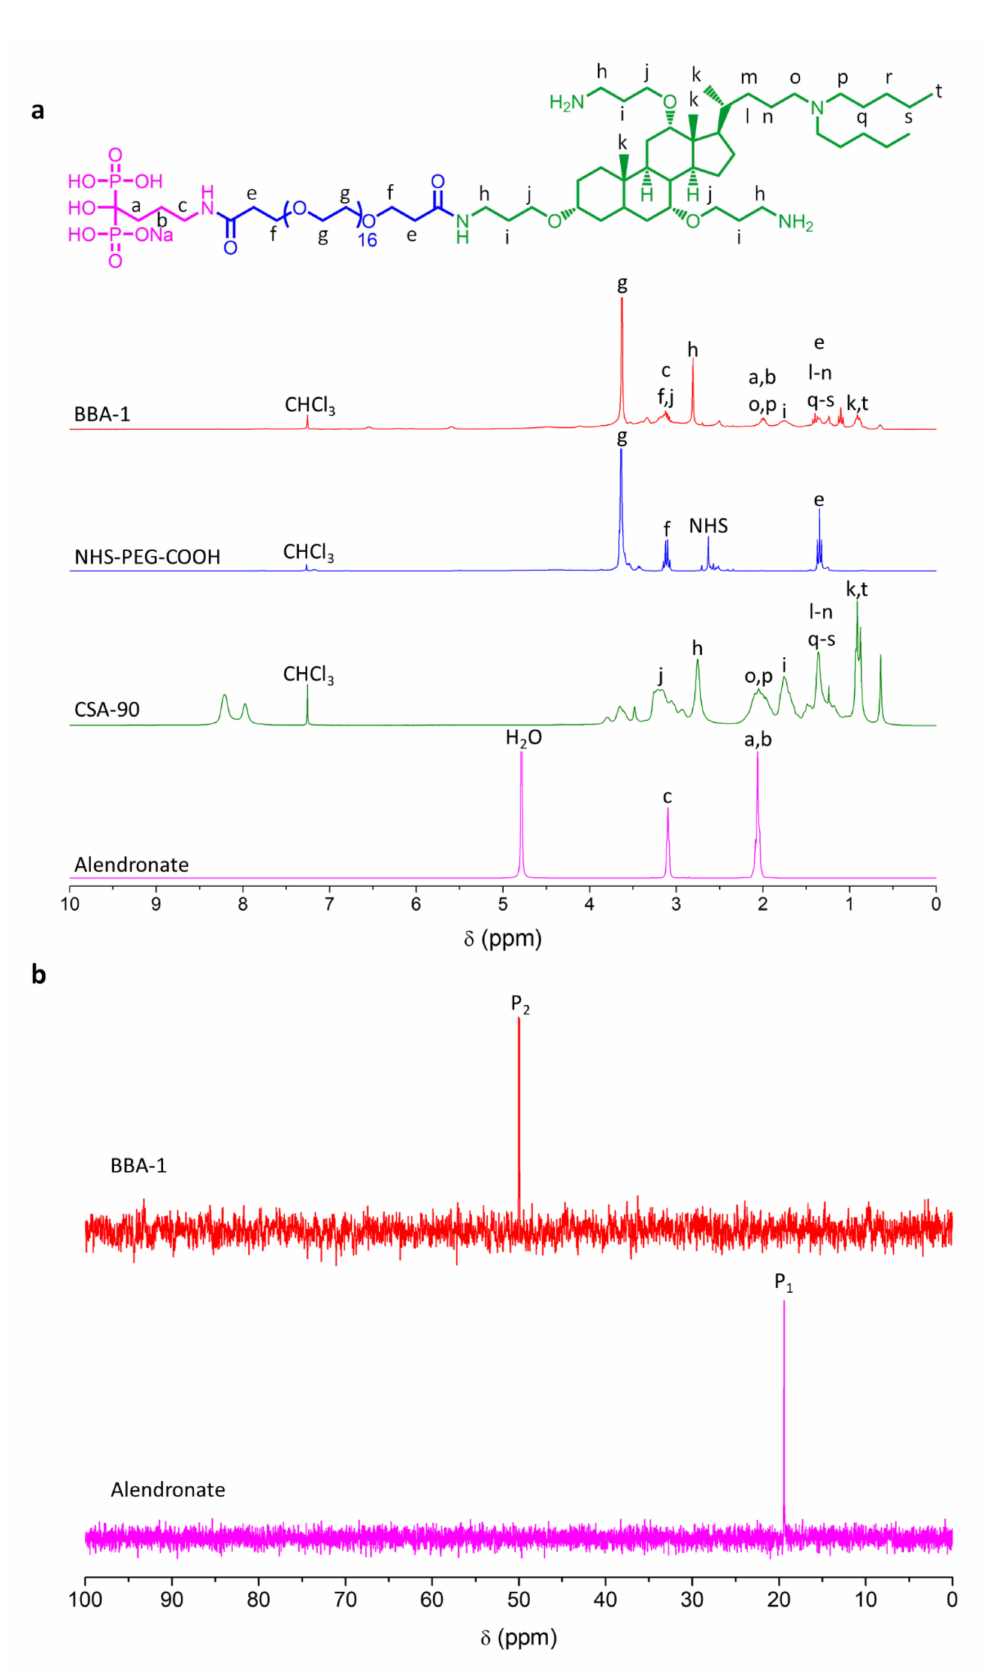
Figure 4. 1 H-NMR and 31 P-NMR characterization. ( a ) 1 H-NMR spectra of BBA-1, NHS-PEG-COOH linker, CSA-90 and alendronate. ( b ) 31 P-NMR of BBA-1 and